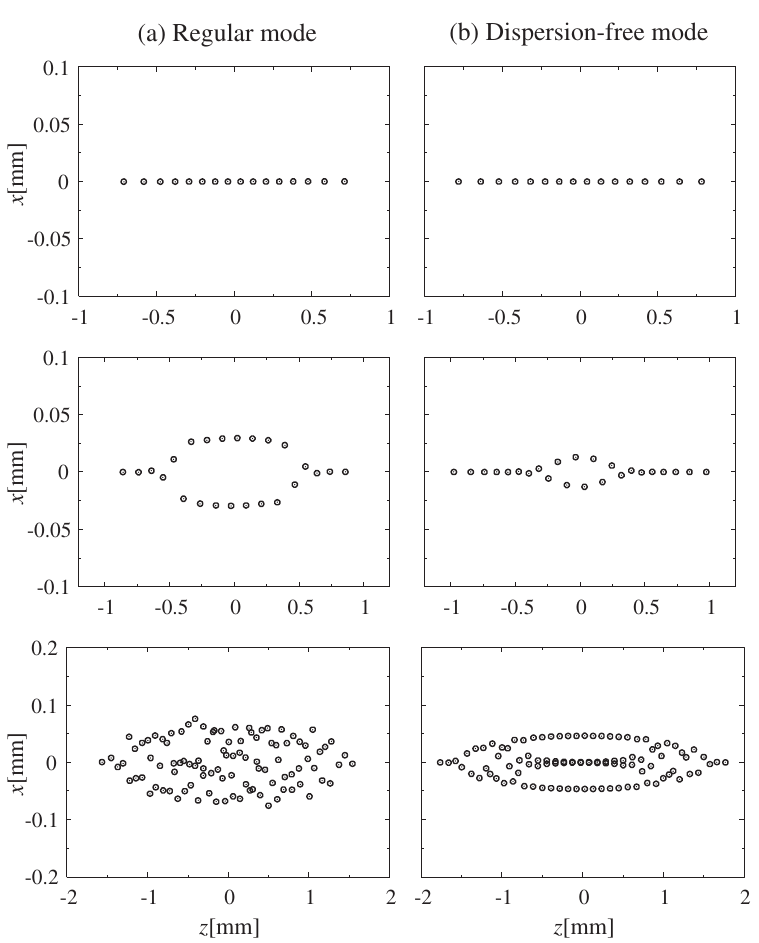
FIG. 3. MD simulation results on Test Ring I. The spatial configurations of bunched crystalline beams have been depicted. The number of 24 Mg (cid:6) ions in a bunch is 16 in the top panels, 24 in the middle panels, and 100 in the bottom panels. Ten rf cavities are introduced in the ring to strictly maintain the high lattice symmetry. The rf amplitude and harmonic number of each cavity have been set at 23.23 Vand 100, achieving the synchrotron tune of 0.23. In the dispersive case, rf amplitude has been set at 29.45 V to achieve the same synchrotron tune. Other parameters are identical to those assumed in Fig. 2.